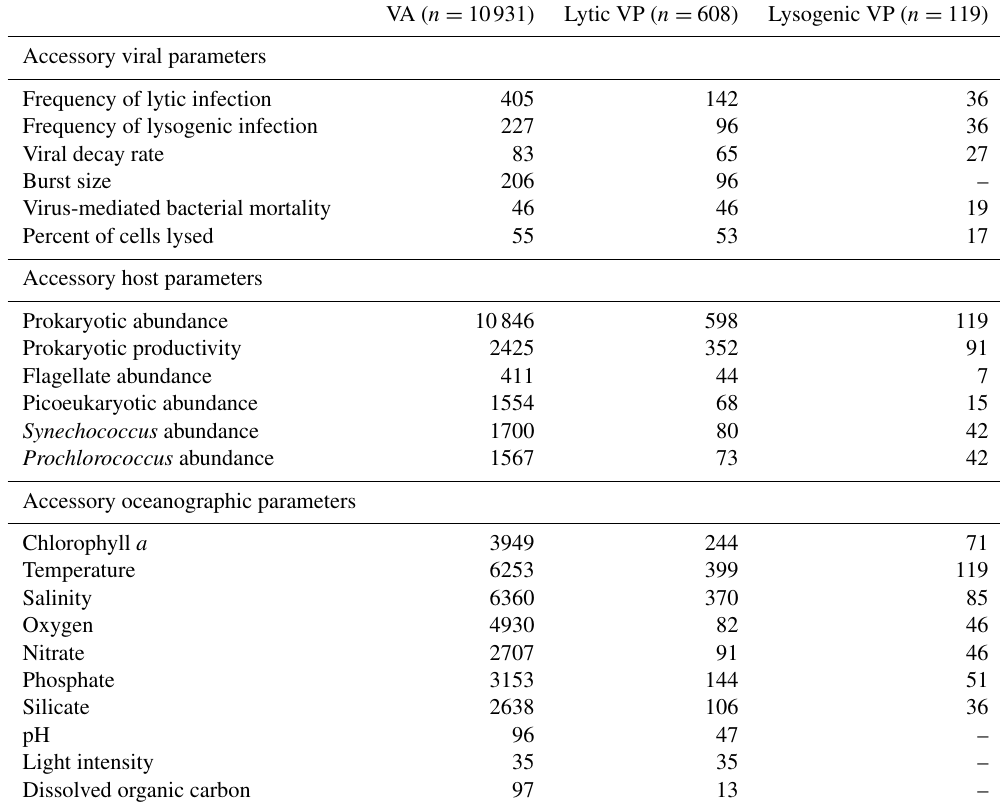
Table 1. Number of accessory viral, host and oceanographic parameters associated with each of the core viral parameters (VA, lytic VP and lysogenic